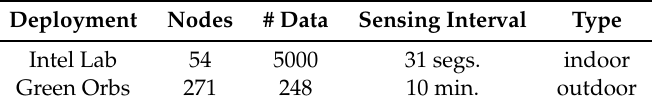
Table 2. Deployment